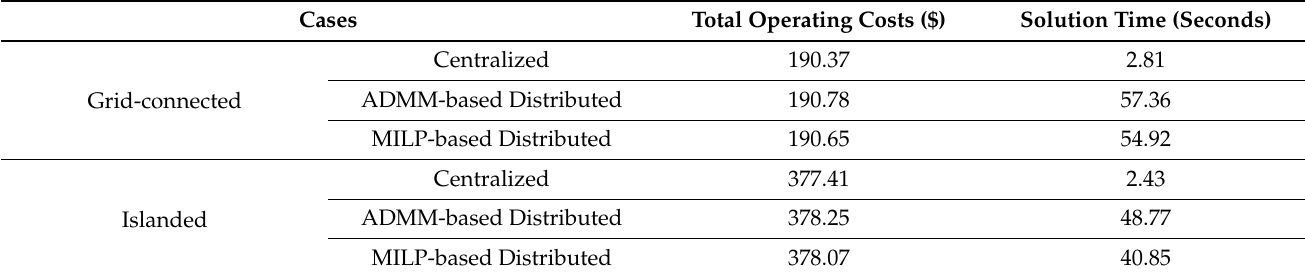
Table 5. Comparison of costs and solution time of different